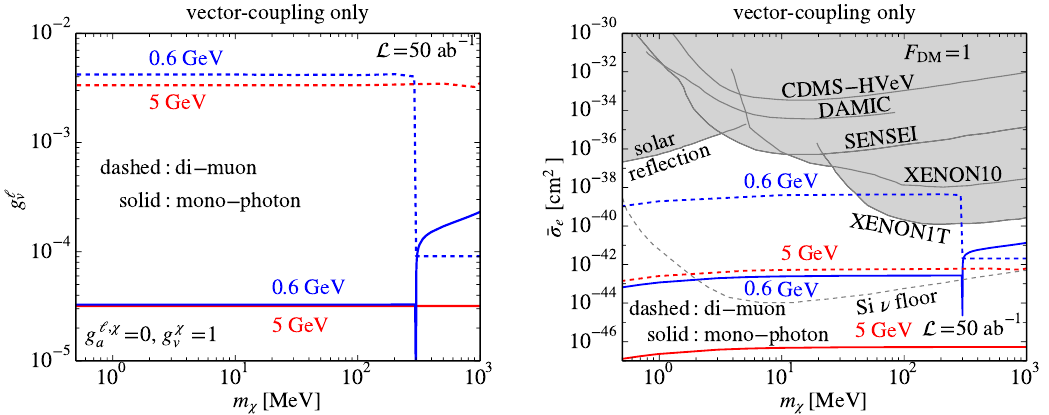
Figure 5 . The expected Belle II 90% C.L. upper bound via visible search (dashed) with 50 ab − 1 in- tegrated luminosity on g ‘ (left panel) and ¯ σ (right panel) in light mediator models where only vector e v couplings are assumed. Two Z 0 masses are considered for the di-muon search analysis: m = 5 GeV Z 0 (red) and m = 0 . 6 GeV (blue). The Belle II mono-photon search constraints (solid) are shown for Z 0 the two Z 0 masses. Constraints from DMDD experiments with F ( q ) = 1 (valid for m ) DM Z 0 (cid:29) αm e are also shown: SENSEI [74], XENON10 [5] and XENON1T [6], CDMS-HVeV [72], DAMIC [73], and solar reflection [22]. The gray dashed line shows the neutrino floor limit for silicon detectors